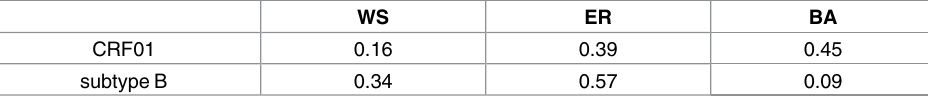
Table 3. Network type posterior probability for the two Swedish